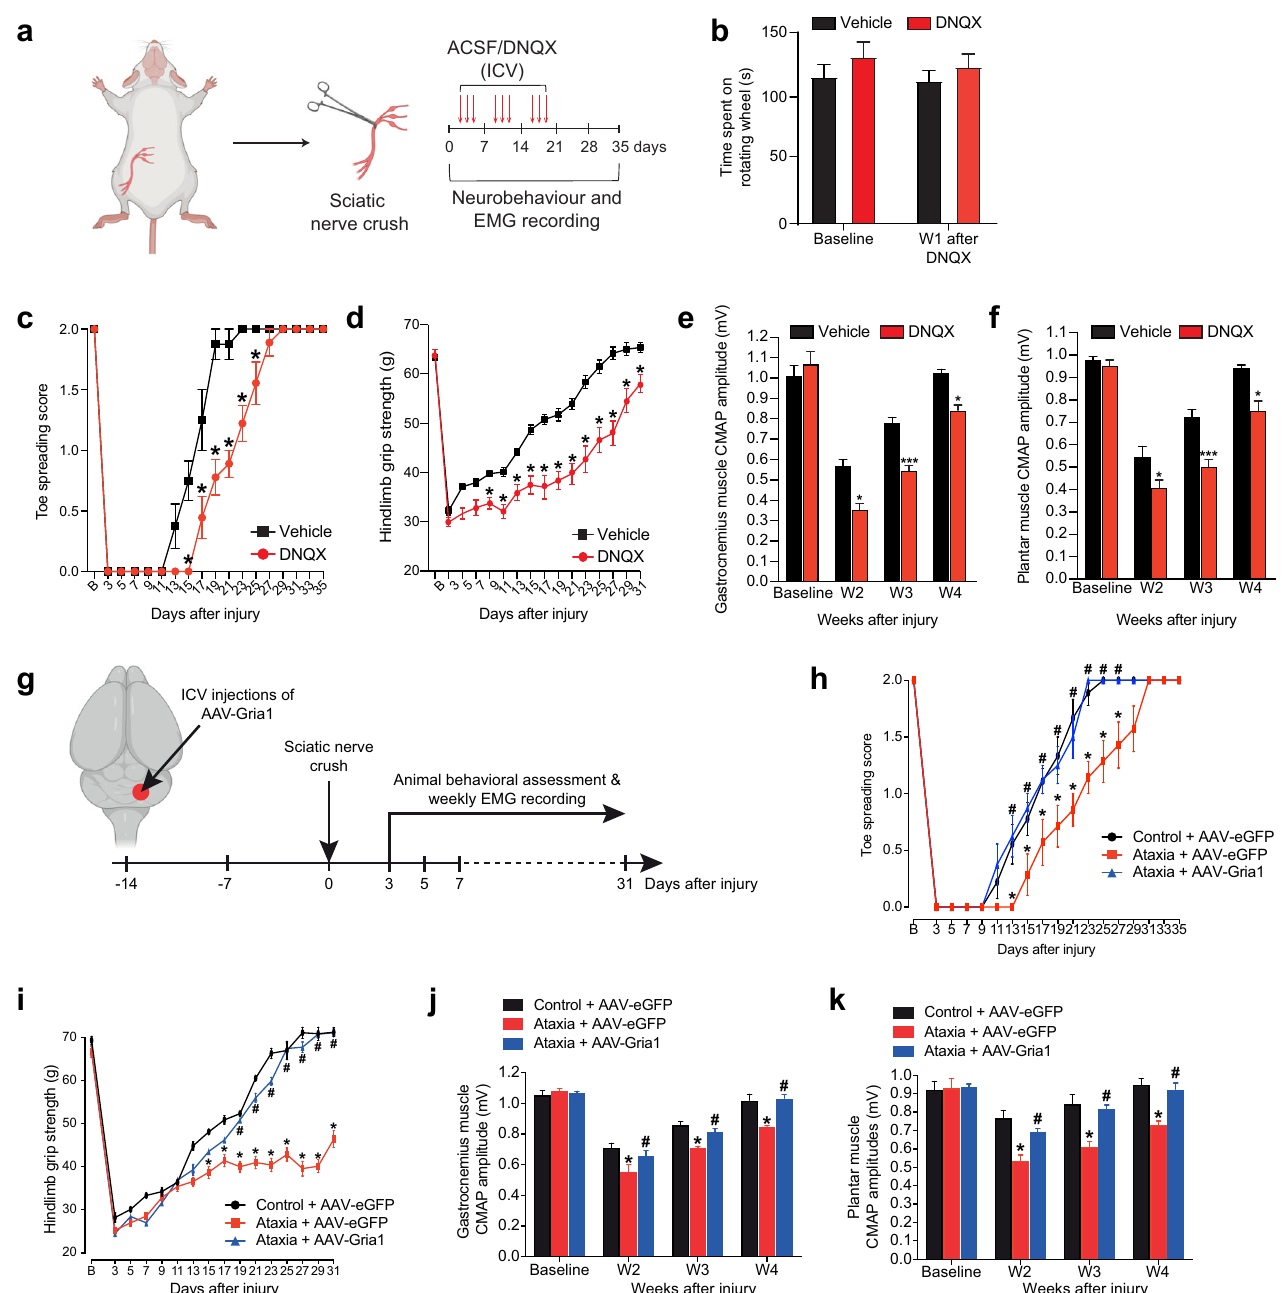
Fig. 6 Gria1 is required for spontaneous motor recovery in ataxia mice after PNI. a Schematic diagram illustrating the experimental paradigm for DNQX treatment and neurobehavior assessment after a single sciatic nerve crush (SNC). Arti fi cial cerebrospinal fl uid (vehicle control) or DNQX was intracerebroventricular injected 3 times a week through a cannula implanted into the DCN. b The retention time on rotarod in DNQX-treated mice was comparable with vehicle-treated controls, suggesting that motor coordination was not affected by DNQX treatment. c Pharmaceutical blockade of AMPA receptors using DNQX severely impaired motor recovery as assessed by toe spreading test. The complete restoration of toe spreading re fl ex was markedly delayed by 6 days in DNQX-treated mice, compared with those treated with vehicle controls. d More drastically, the hindlimb grip strength of DNQX-treated mice was signi fi cantly lowered from days 9 to 31 post-injury, while vehicle- treated mice showed gradual and complete restoration of hindlimb grip strength. e and f The compound muscle action potential (CMAP) amplitudes of proximal gastrocnemius ( e ) and distal plantar muscle ( f ) were reduced in DNQX-treated mice compared with vehicle-treated controls. g Two weeks before SNC, ataxia mice received an intracerebroventricular injection of AAV-Gria1 or AAV-eGFP (control) into the cerebellum. Animal behavioral assessments were performed on every alternate day starting from day 3 after crush. h and i Ataxia mice treated with AAV-Gria1 showed complete motor recovery similar to the control mice injected with AAV-eGFP. j and k The CMAP amplitudes of proximal gastrocnemius ( j ) and distal plantar muscle ( k ) from ataxia mice treated with AAV-Gria1 restored to baseline level of controls. Values represented the mean ± SEM ( n = 9 – 10 per group in b – f ); ( n = 7 for ataxia + AAV-eGFP group; n = 9 for control + AAV-eGFP and ataxia + AAV- Gria1 groups in h – k ); * P < 0.05; *** P < 0.001, compared with vehicle-treated controls in c – f , or control mice with AAV-eGFP in h – k ; # P < 0.05, compared with ataxia mice with AAV-eGFP in h – k , two-way ANOVA with repeated measures followed by post hoc Bonferroni test. Detailed statistics analyses comparing CMAP amplitude data points across time within groups are available in Supplementary Table